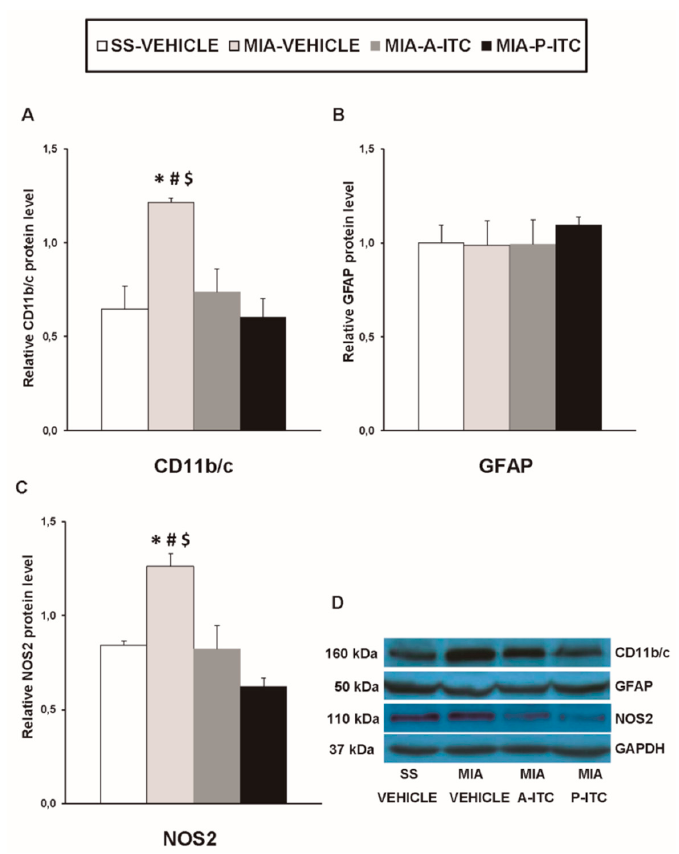
Figure 7. A-ITC and P-ITC treatments inhibit the overexpression of CD11b/c and NOS2 in the hippocampus of mice with osteoarthritis pain. The relative protein levels of ( A ) CD11b/c, ( B ) GFAP, and ( C ) NOS2 in the hippocampus of MIA-injected mice treated with A-ITC, P-ITC, or vehicle are presented. The SS-injected mice treated with vehicle were used as controls. ( D ) Representative blots for CD11b/c (160 kDa), GFAP (50 kDa), NOS2 (110 kDa), and GAPDH (37 kDa). All proteins are expressed relative to GAPDH levels. In all panels, * denotes significant differences vs. SS-injected mice treated with vehicle, # vs. MIA-injected mice treated with A-ITC and $ vs. MIA-injected mice treated with P-ITC ( p < 0.05; one-way ANOVA followed by the Student–Newman–Keuls test). The results are presented as the mean ± SEM; n = 4 samples per experimental group.